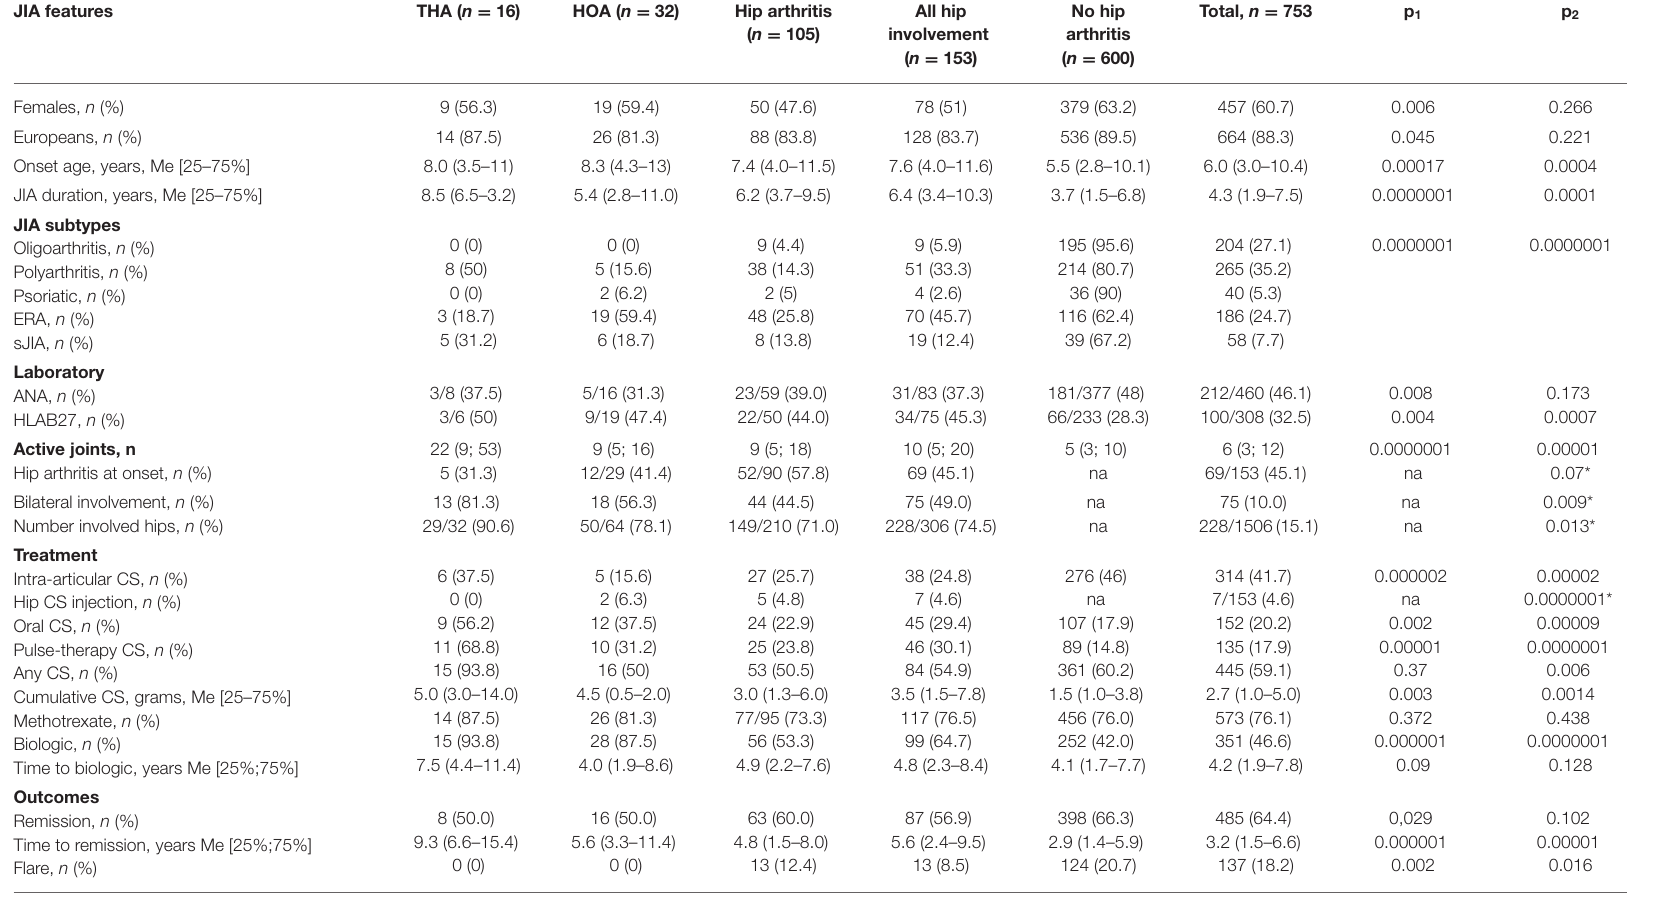
TABLE 2 | The features of juvenile idiopathic arthritis in different types of hip